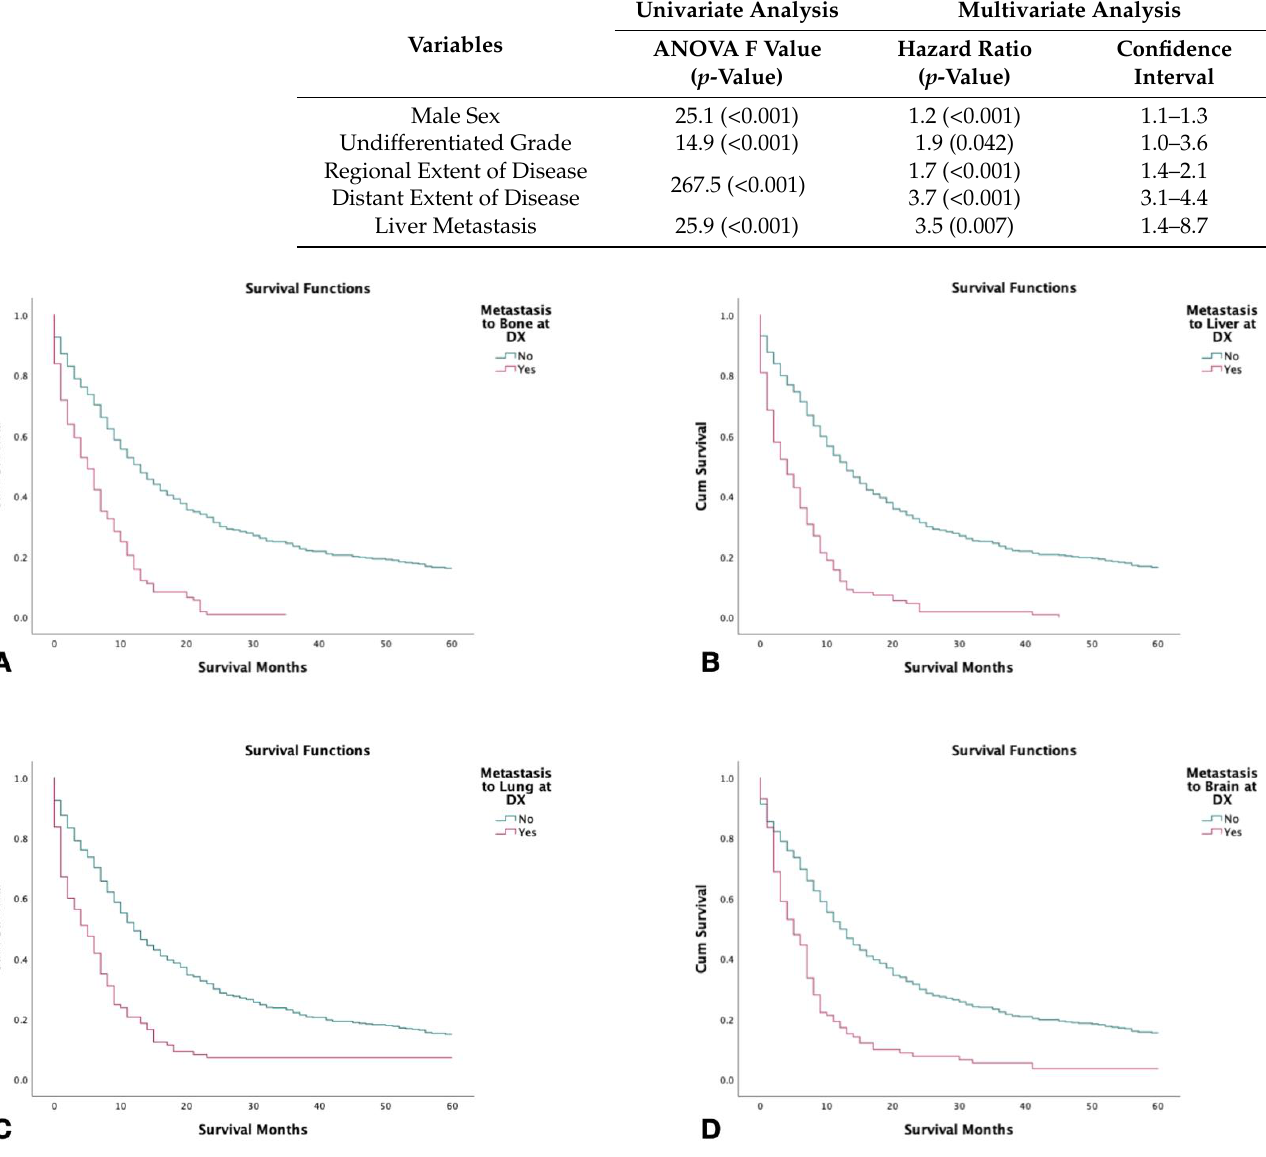
Figure 3. Kaplan–Meier survival curves of 2126 patients with combined small-cell lung cancer from SEER database by metastasis to liver at the time of diagnosis (2000–2018). ( A ) Survival by metastasis to the bone at the time of diagnosis. ( B ) Survival by metastasis to the liver at the time of diagnosis. ( C ) Survival by metastasis/spread to the lungs at the time of diagnosis. ( D ) Survival by metastasis to the brain at the time of diagnosis. Log rank (Mantel – Cox) analysis ( χ 2 ) performed on each independent variable ( p < 0.001).